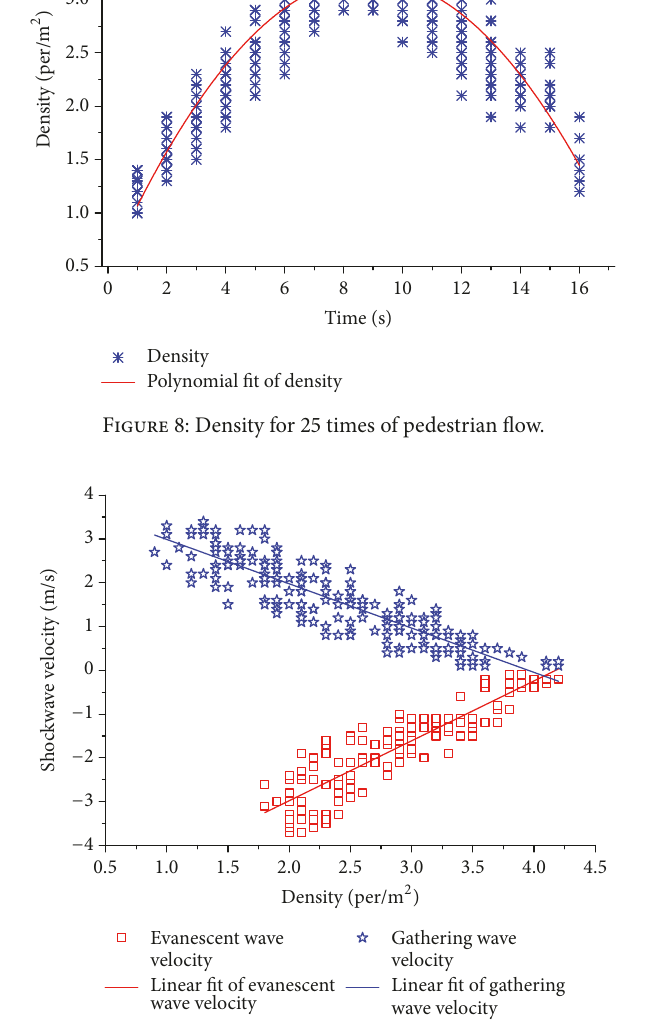
Figure 9: Relationship between shockwave velocity and